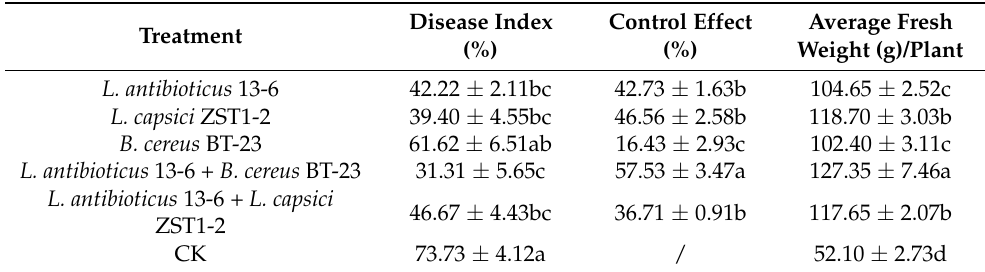
Table 1. Efficiency of biocontrol agents as co-culture and mono-culture against clubroot disease and plant growth promotion.